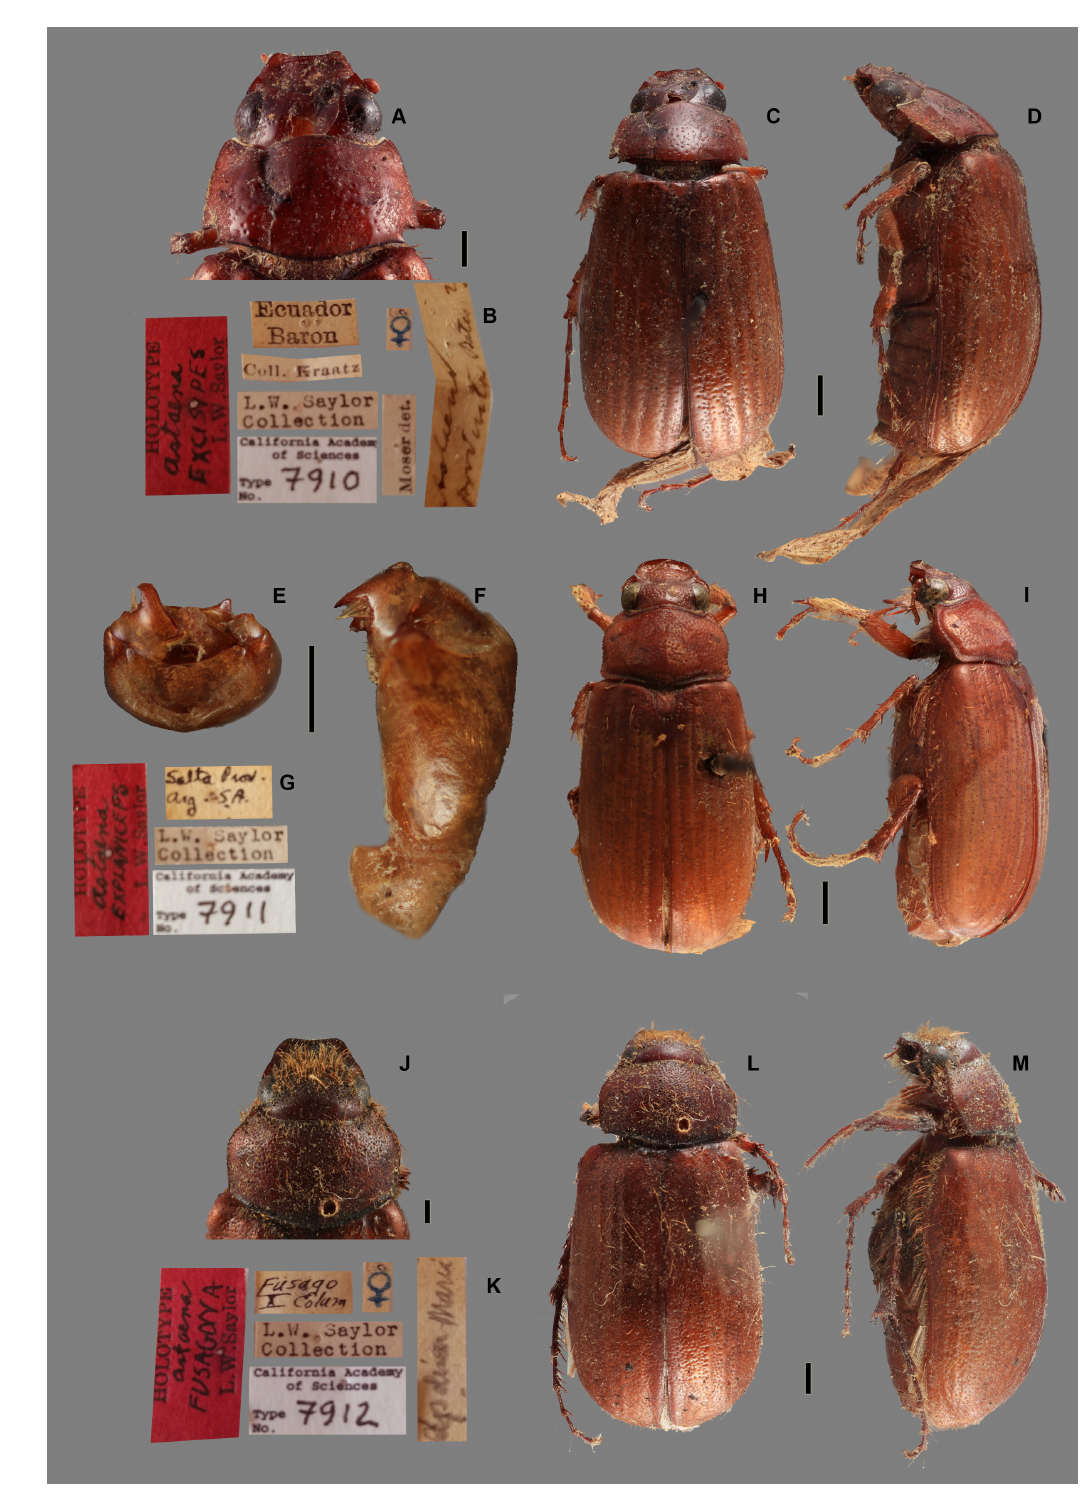
Fig. 2. A–D . Astaena excisipes Saylor, 1947, holotype, ♀ (Type No. 7910; CAS). – E–I . A. explaniceps Saylor, 1947, holotype, ♂ (Type No. 7911; CAS). – J–M . A. fusagona Saylor, 1946, holotype, ♀ (Type No. 7912; CAS). A, J . Head and pronotum, dorsal view. B, G, K . labels. C, H, L . Habitus, dorsal view. D, I, M . Habitus, lateral view. E . Parameres, dorsal view. F . Aedeagus, lateral view. Scale bars: A, E–F, J = 0.5 mm; C–D, H–I, L–M = 1